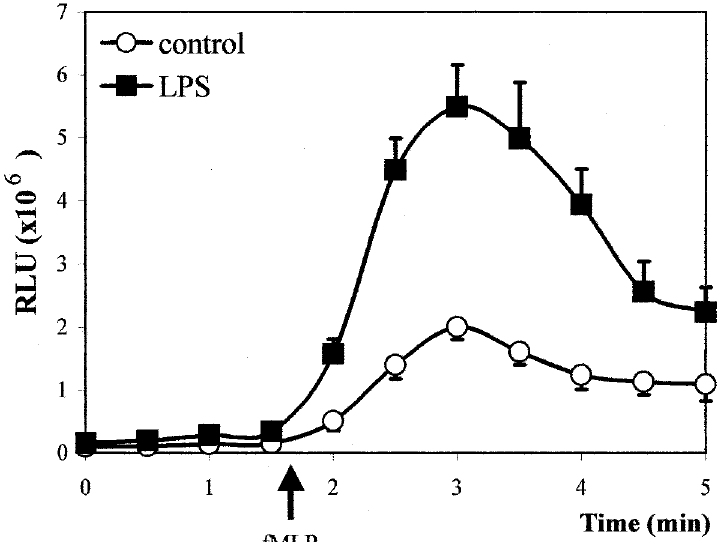
FIG. 1. Time-course of the superoxide anion production from human peripheral blood mononuclear cells in the absence (control) or presence of lipopolysaccharide (LPS) (10 m g/ml for 30min). Superoxide anion production was measured by the luminol-dependent chemiluminescence technique (expressed in relative light units (RLU)). Superoxide anion production was measured every 30sec, 1.5min before and 3.5min after fMLP (1 m M) stimulation. The whole curves were compared using two- way analysis of variance ( p < 0.001, n =